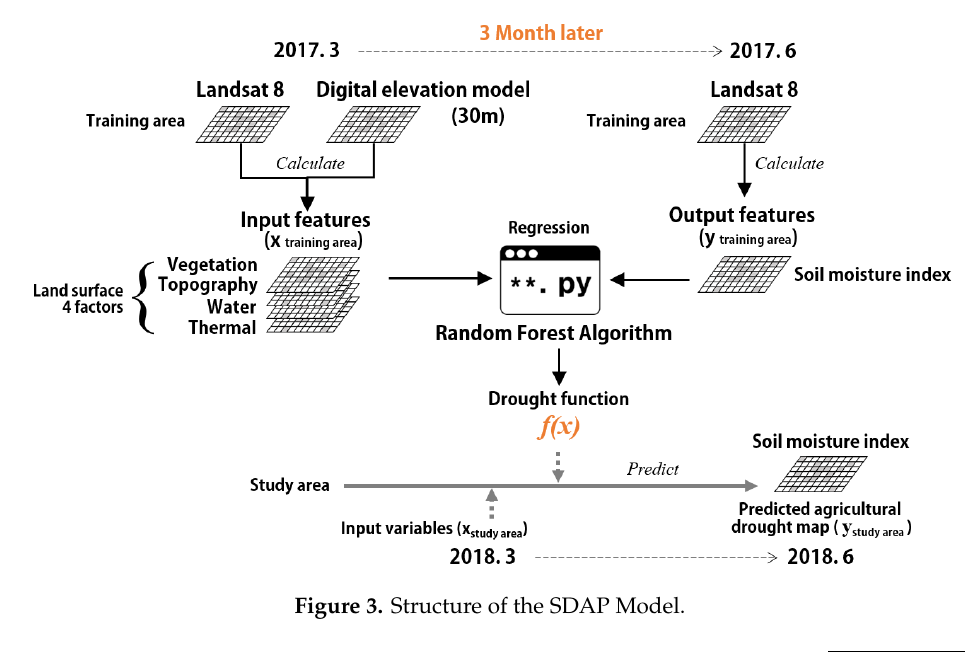
Figure 2. Framework of linked the severe drought area prediction (SDAP) model and the SD (system dynamics) model.